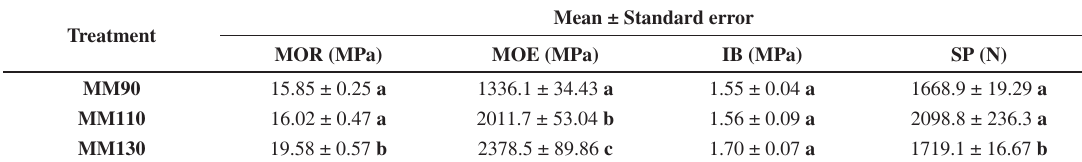
Table 2. Mean values of the mechanical properties of the particleboards. Treatment